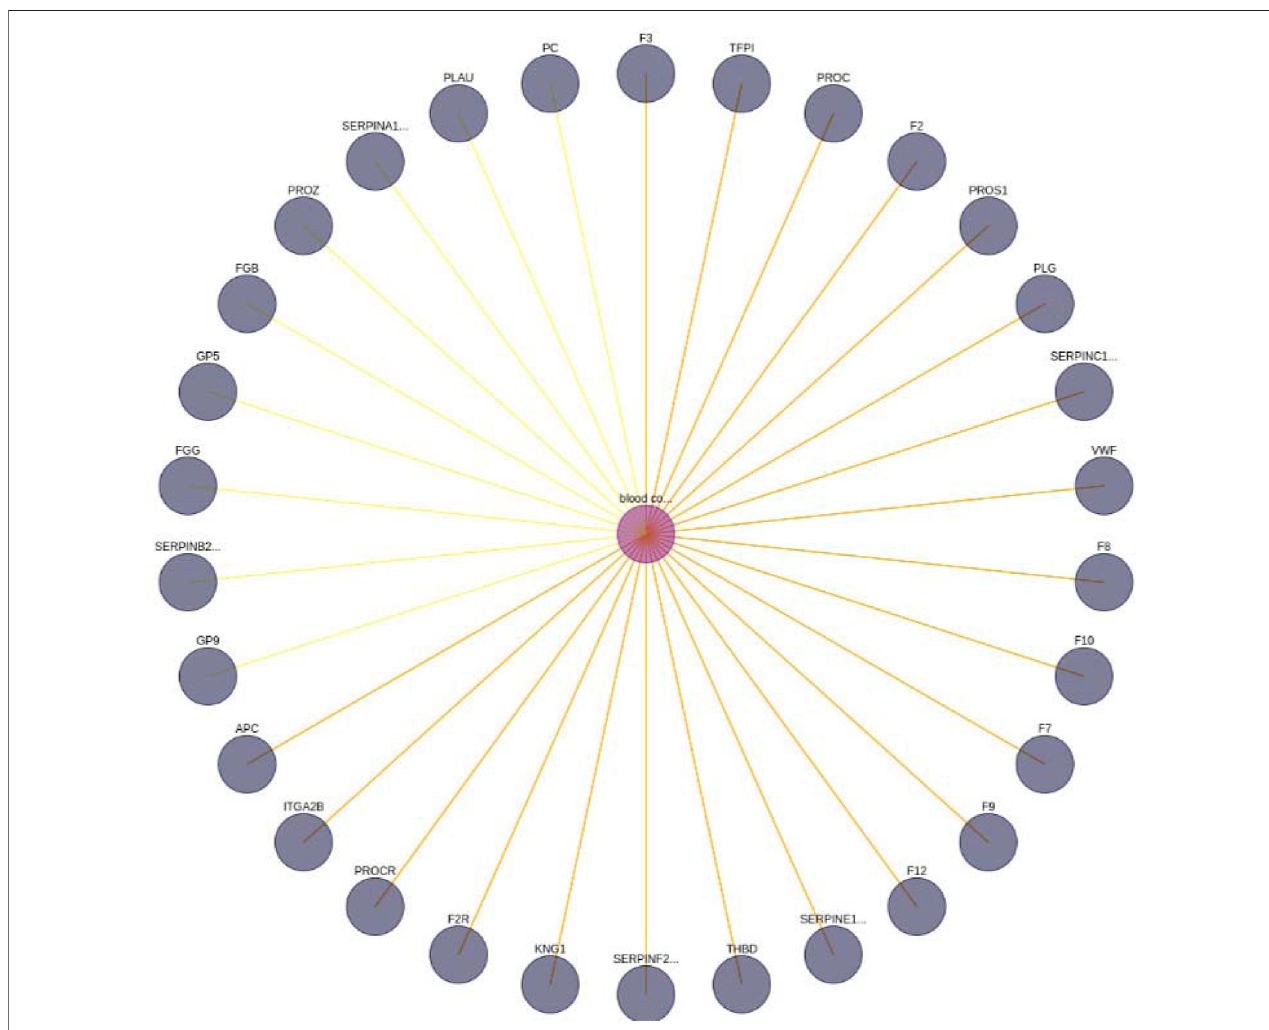
FIGURE6| Bloodcoagulation — geneinteraction network.Alimitof30hasbeenset.Inaddition,theyellow edgesrepresentasetofBioTagME unpredicted edges (extracted by external databases). Instead, the orange ones (yellow + red) are edges both predicted (by BioTagME) and extracted from the external databases.